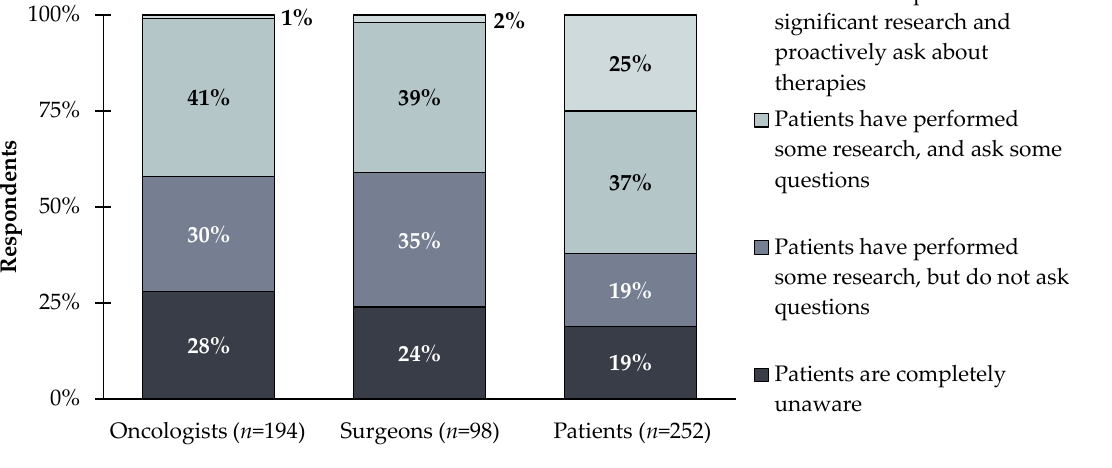
Figure 3. Oncologists and surgeons ( n = 302) were asked the following question. Which of the following best describes your patients’ awareness of biomarkers and targeted therapies for their cancer? Patients ( n = 242) were asked: Which of the following best describes your awareness of biomarker testing? 25% of patients believe they have performed significant research and proactively ask about therapies compared to the 1% of oncologists and 2% of surgeons.